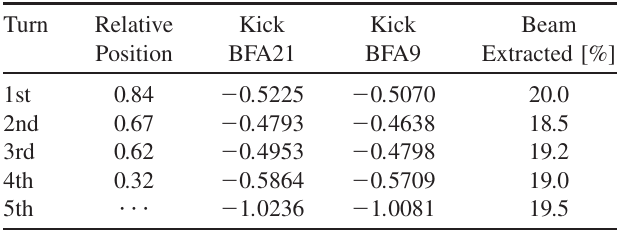
TABLE II. Parameters used in the simulations to achieve the equal intensity extraction. The second column is the relative position of the beam and septum blade for a bi-Gaussian beam. The third and fourth columns show BFA kicks in mrad calculated from the needed closed orbit. The last column shows extracted efficiency for each of the five turns.